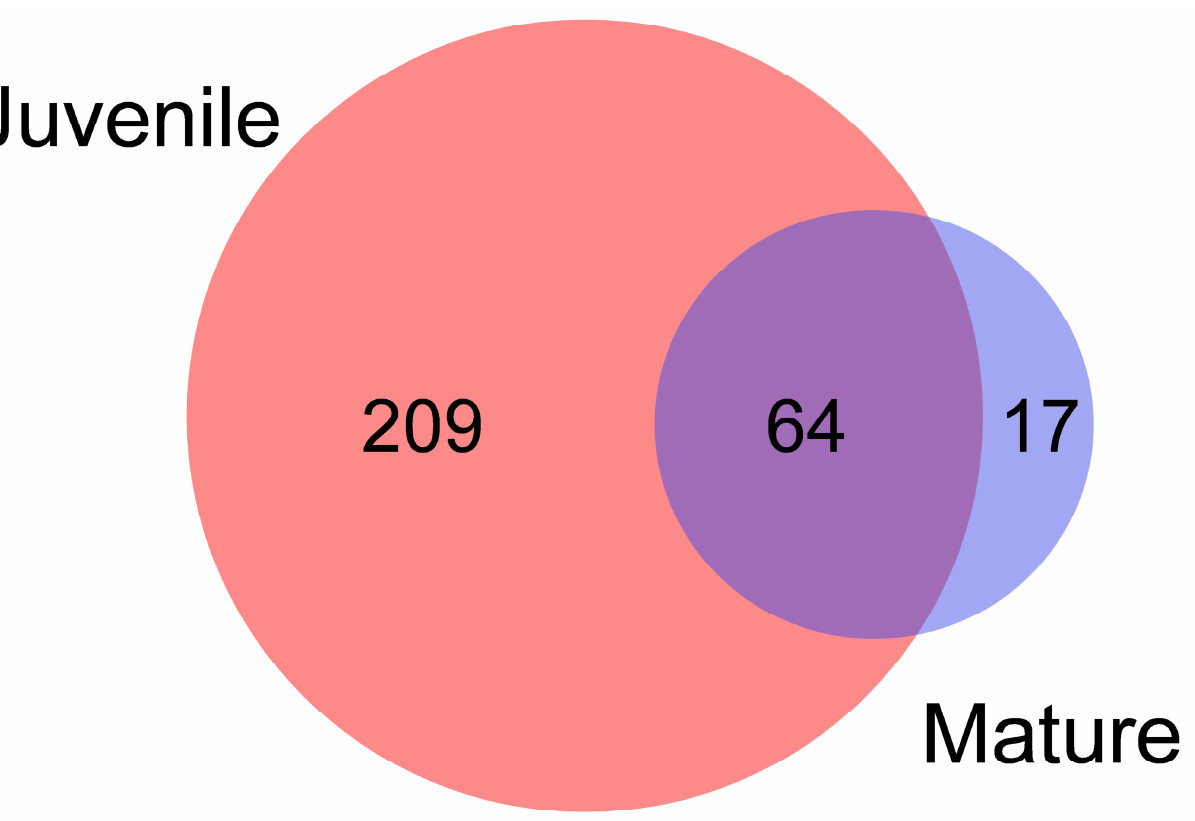
Figure 2. LncRNAs detected in fast skeletal muscle GS FLX 454 transcriptomes. Venn diagram representing LncRNAs identified in the GS FLX 454 transcriptomes of juvenile and mature gilthead sea breams from Garcia de la serrana et al. (2012) [55]. The number of lncRNAs found only in juveniles or matures is shown inside the individual circles, while lncRNAs shared are shown in the